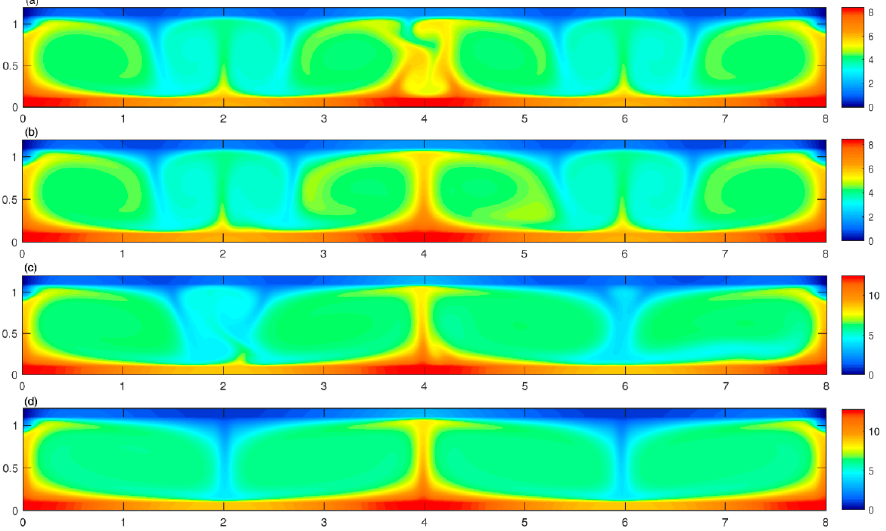
Figure 8. Occurrence of flow mode transition at time period ( a ) 1.24 s and ( b ) 1.25 s, and at time period ( c ) 2.35 s and ( d ) 2.36 s.